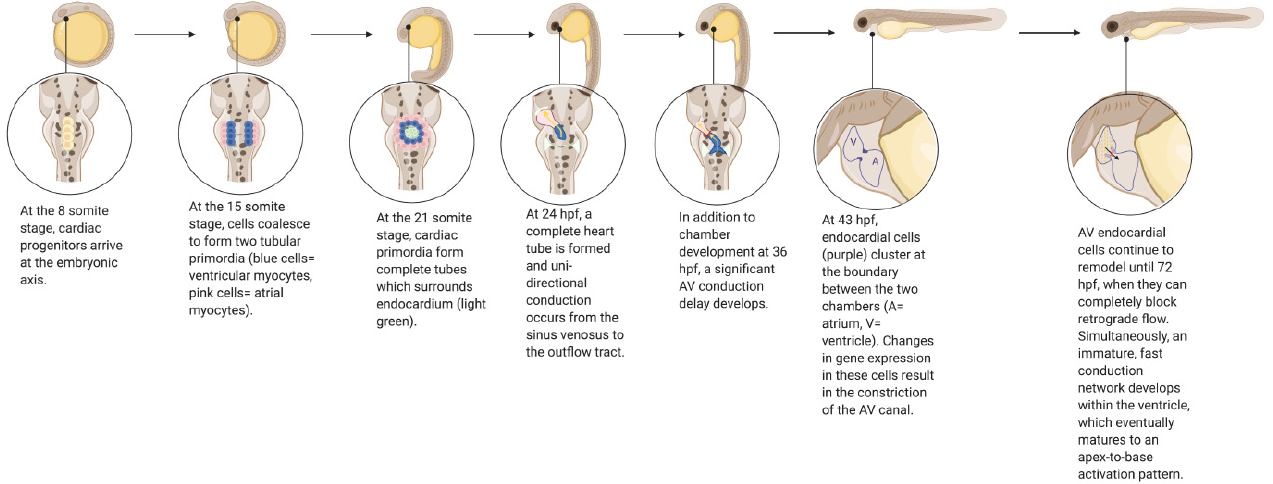
Figure 1. Development of the Zebrafish Cardiovascular System. Created with BioRender.com.